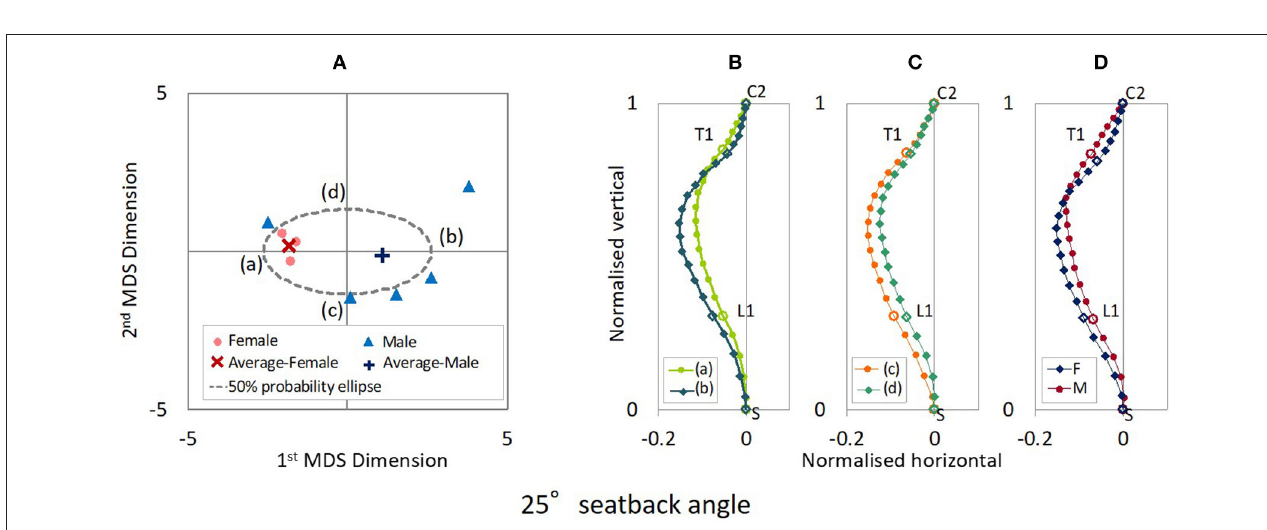
FIGURE 4 | (A) MDS distribution map of spinal alignments for the 25 ◦ seatback angle. (B) Spinal alignments estimated at the intersections of the 50% probability ellipse with the 1st MDS dimension (a,b) and (C) the 2nd MDS dimension (c,d), and (D) the female and the male average points (F and M).